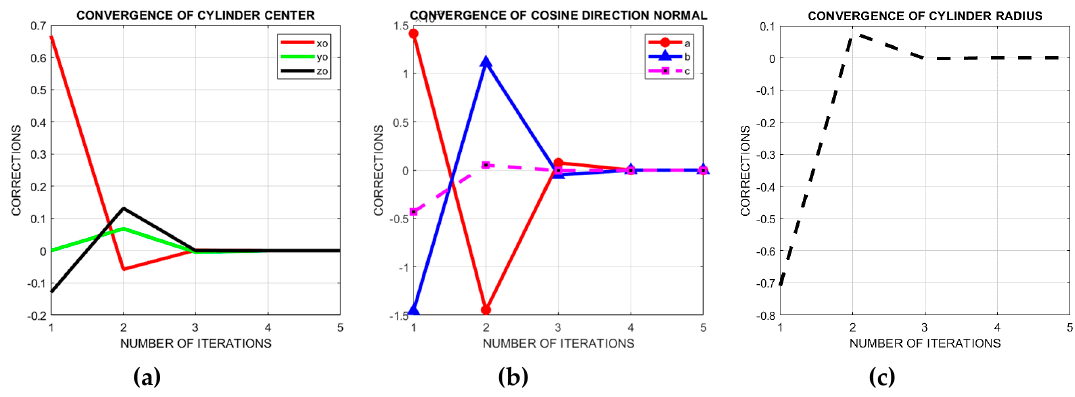
Figure 10. Nonlinear least squares cylinder fitting parameters converged to optimal.